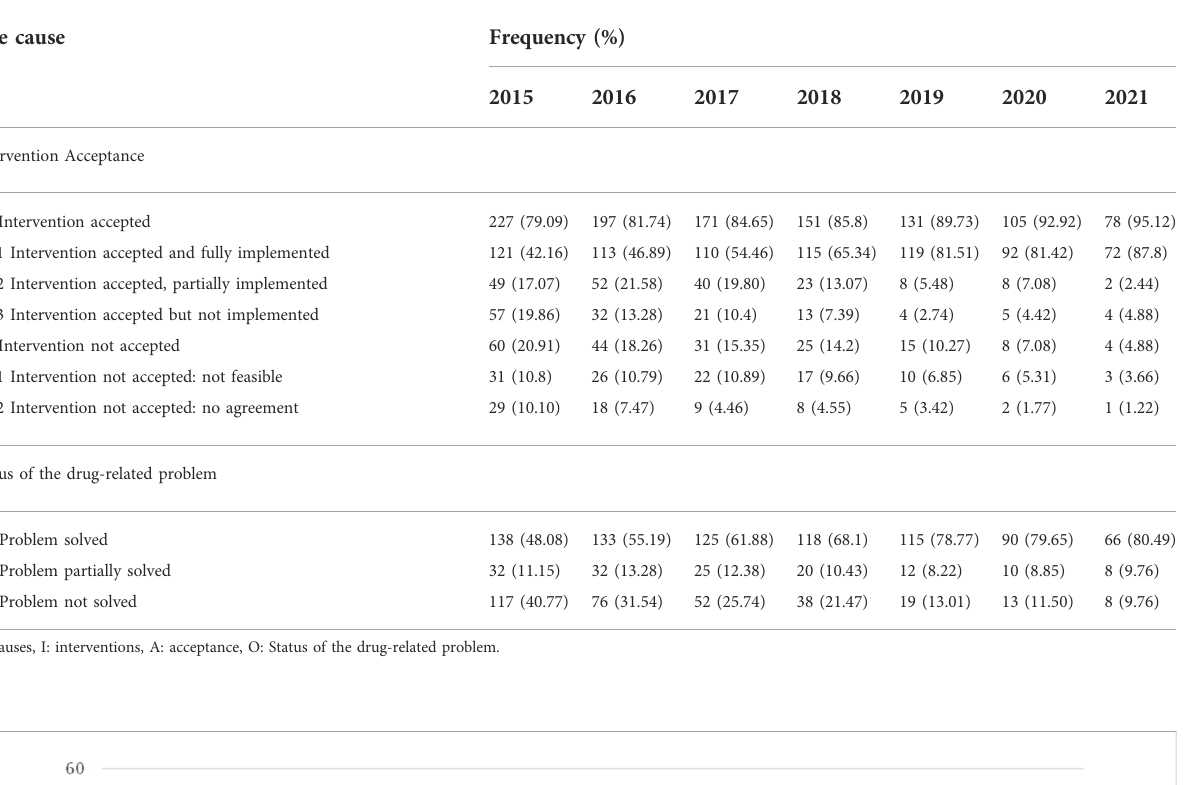
TABLE 1 ( Continued ) Types of irrational drug uses and DTC